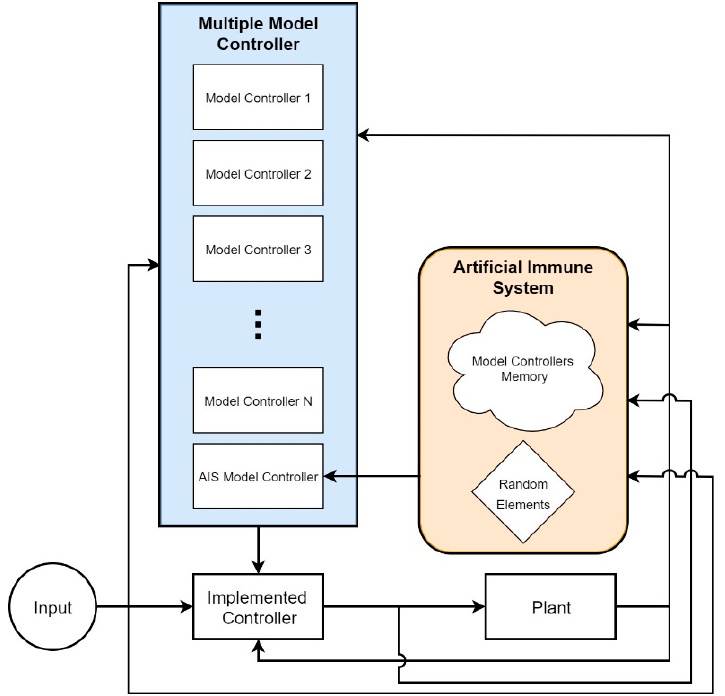
Figure 9. Diagram demonstrating an integration of the AIS with a multiple model controller where the AIS adds a model to the multiple model controller.